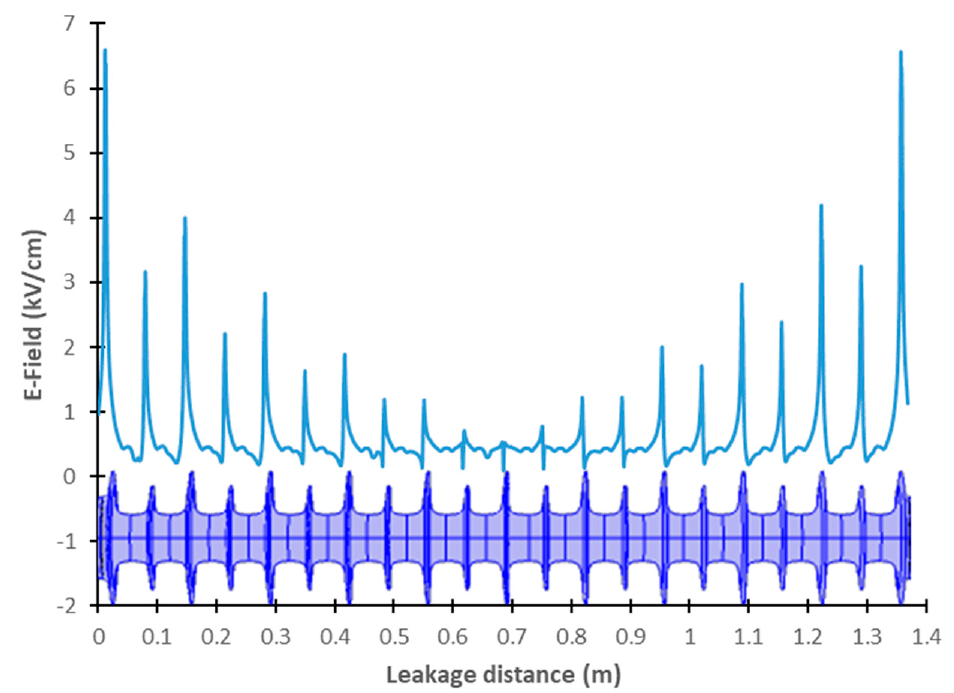
Figure 2. E-field distribution at the surface of the polluted 69 kV composite insulator.